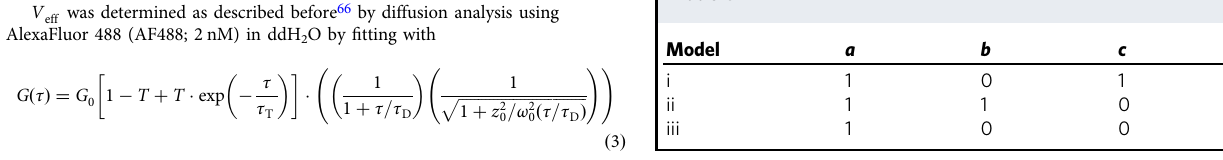
Table 1 Values of constants in Eq. (4) for different FCS fi t